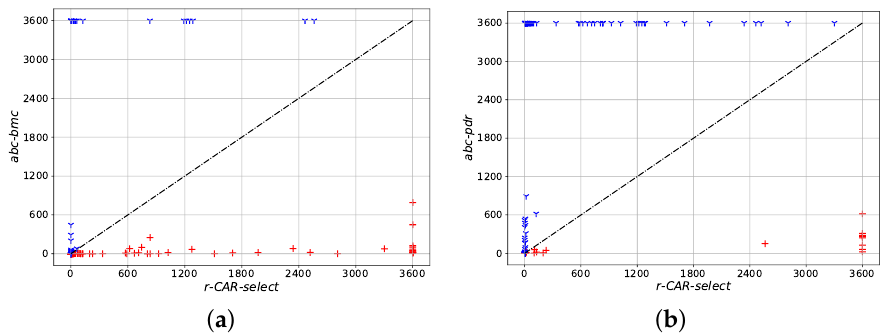
Figure 5. Comparison of time spent by r-CAR-select with other algorithms. ( a ) Comparison on time spent by r-CAR-select and BMC. ( b ) Comparison on time spent by r-CAR-select and IC3/PDR.